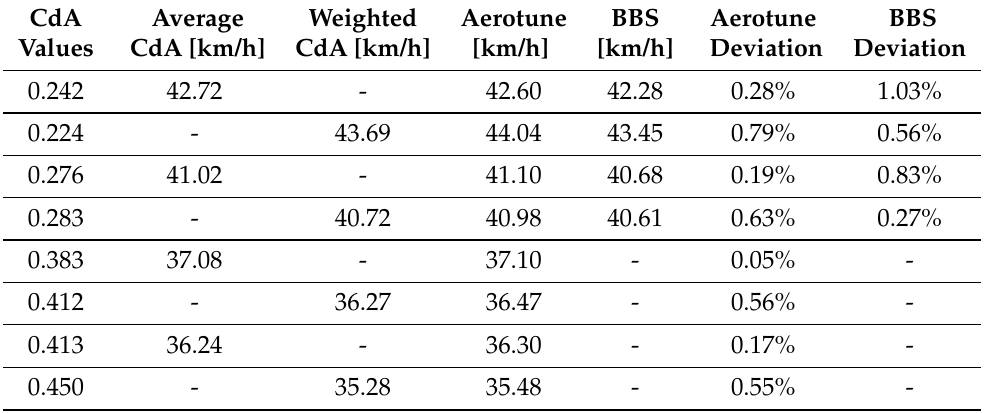
Table 5. Predicted average speeds and comparison with tools Aerotune and Best Bike